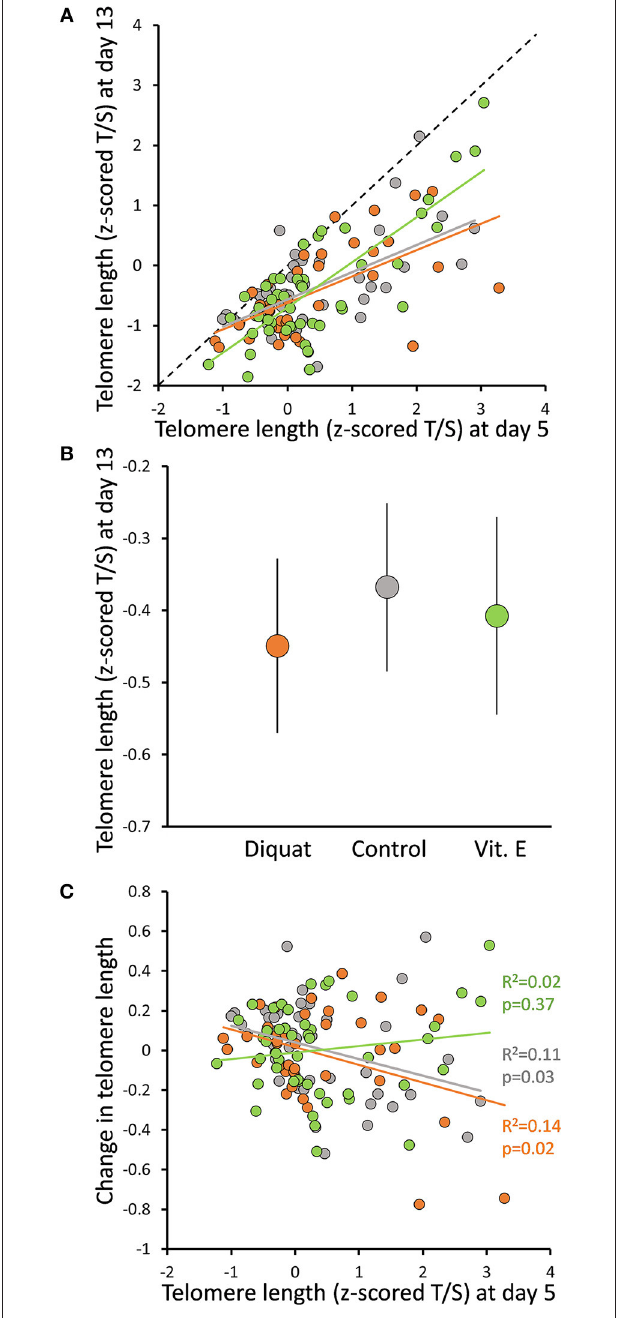
FIGURE 2 | Effect of experimental treatments (diquat injections, vitamin E supplementation or control) on (A) the relationship between telomere length at day 5 and 13, (B) telomere length at day 13 (mean ± s.e.), and (C) the relationship between change in telomere length from day 5 to 13 of age (after correcting for regression to the mean; Verhulst et al., 2013) and telomere length at day 5. When telomere lengths are shown, we report T/S ratios transformed for day 5 and 13 data pooled to a standard normal distribution (i.e., z-scored T/S). The dashed line in (A) describes equal values of x and y, thus the vertical distance indicates the amount of telomere shortening. R 2 and p -values in (C) correspond to simple correlations within groups; see main text for estimates derived from full statistical models. Color codes for treatments are: orange for diquat, gray for control and green for vitamin E-treated